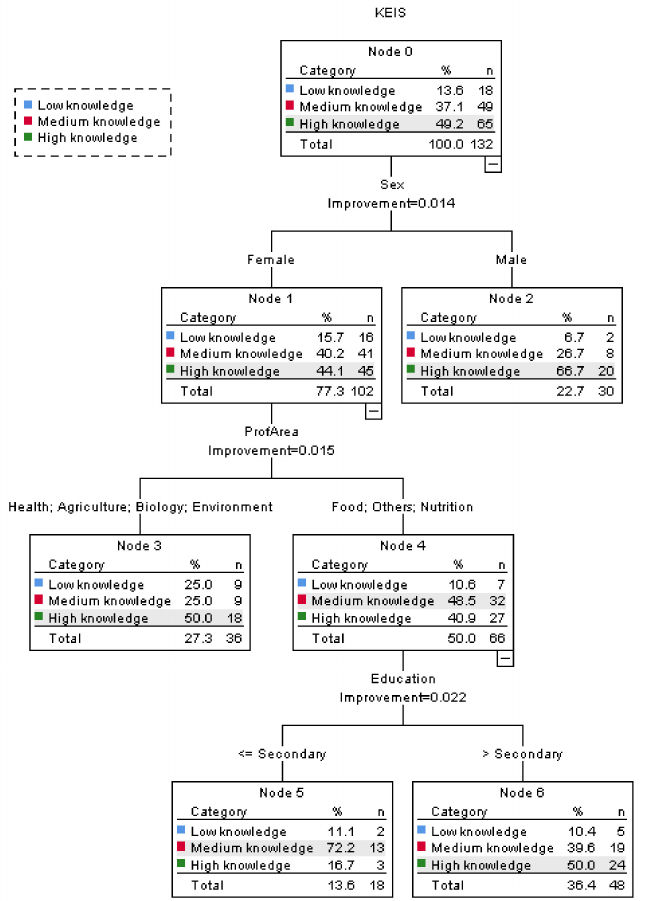
Figure 2. Tree classification for the influence of sociodemographic variables on the level of knowledge about edible insects (EI) and sustainability